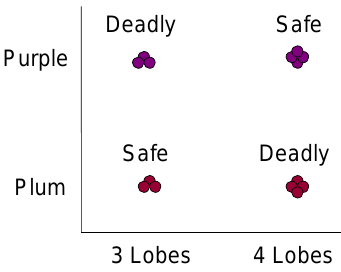
Figure 11. A hypothetical ecological exclusive-or (XOR) category task. To our knowledge, nature almost never presents this kind of foraging or predator-avoidance problem to living organisms, and it is a graceful state of nature that this is so.